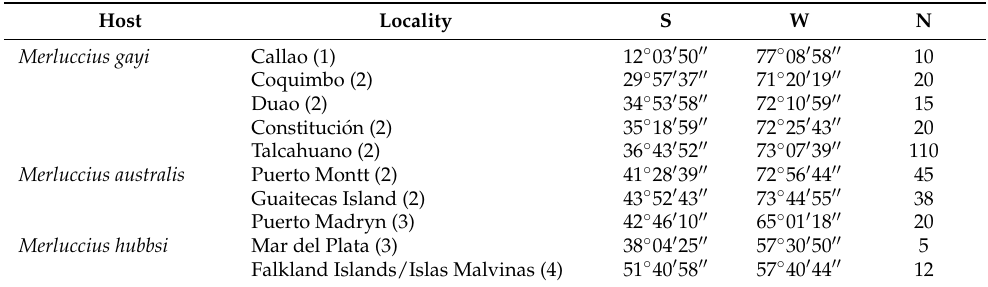
Table 1. The South American species of the genus Merluccius studied, locality, geographic coordinates, and host sample